Question: Give a one-sentence summary of this figure.
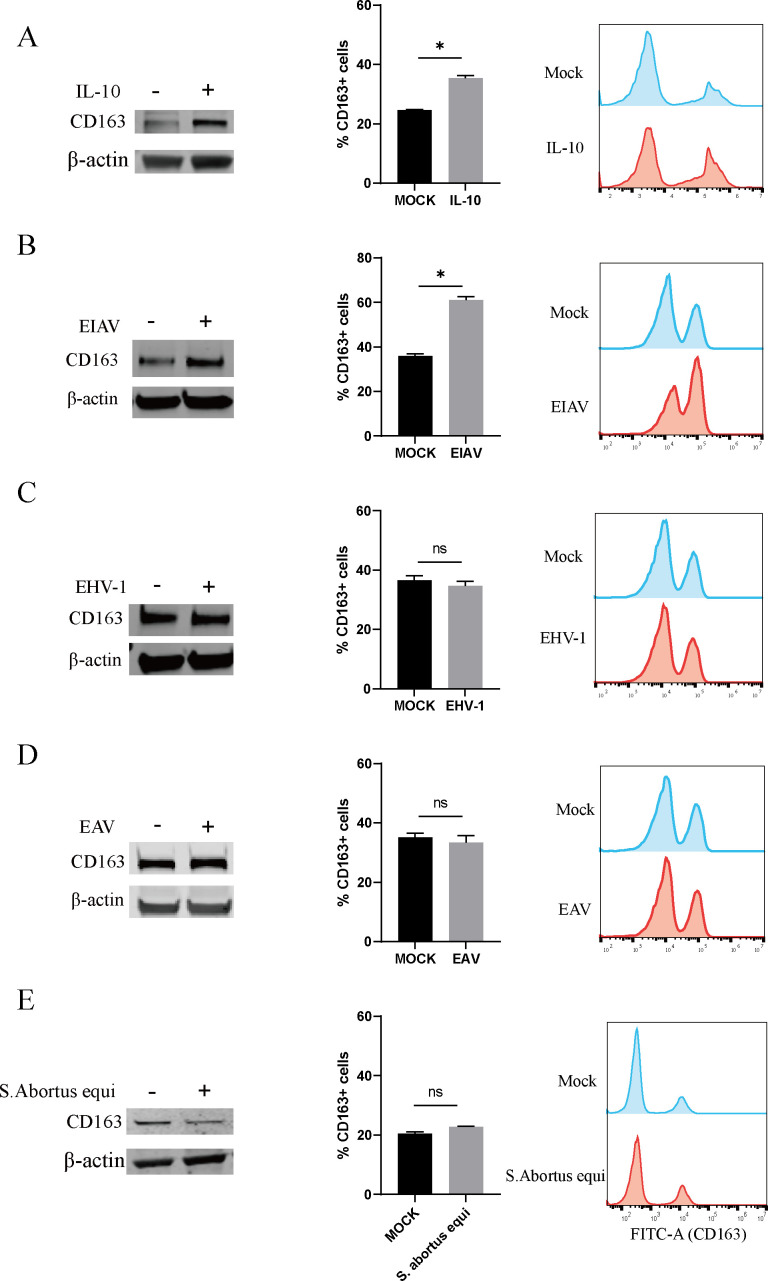
Answer: Analysis of CD163 expression in pathogen-infected equine macrophages. CD163 protein levels and the percentage of CD163-positive cells were quantified using Western blotting (left panels) and flow cytometry (right panels), respectively. The “mock” columns denote uninfected, unstimulated negative control cells. ( A ) Positive control demonstrating CD163 upregulation following IL-10 stimulation. ( B–E ) CD163 expression profiles following infection with ( B ) EIAV, ( C ) EHV-1, ( D ) EAV, and ( E ) S. abortus equi . Flow cytometry histograms display FITC-fluorescence intensity (CD163 expression) on the x-axis and cell count on the y-axis. Data are shown as mean ± SEM of three independent biological replicates. Statistical differences relative to the mock control were assessed via Student’s t -test (*, P < 0.05; **, P < 0.01; ***, P < 0.001).